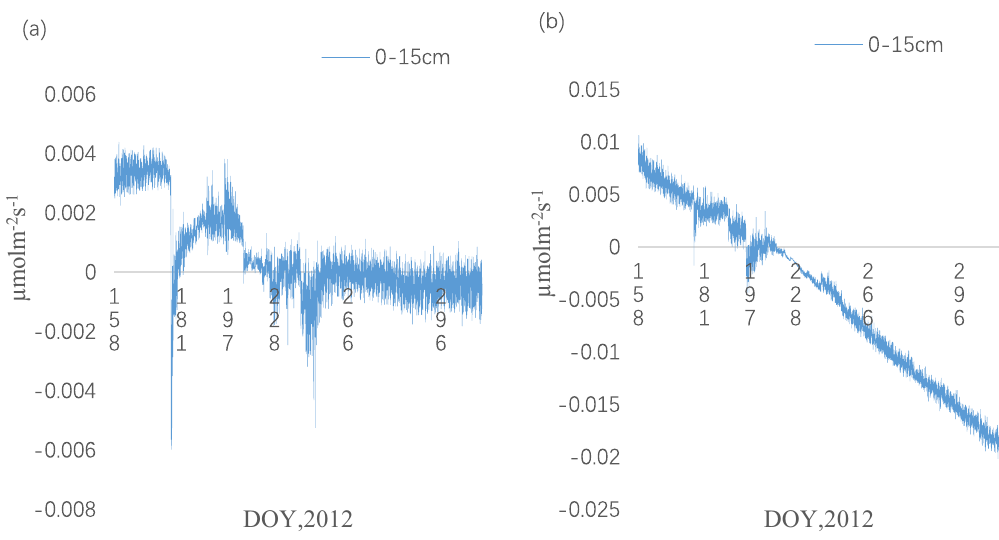
Figure 7. Seasonal variation of CO2 storage (0–15 cm) (a) in the TC treatment (b) in the MC